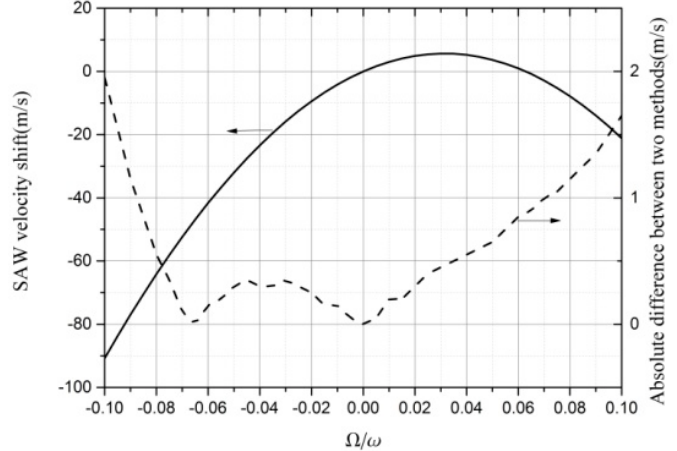
Figure 3. SAW velocity shift and the difference between the methods of FEM and partial–wave analysis method depending on the ratio of the rotation rate by the wave frequency Ω / ω .